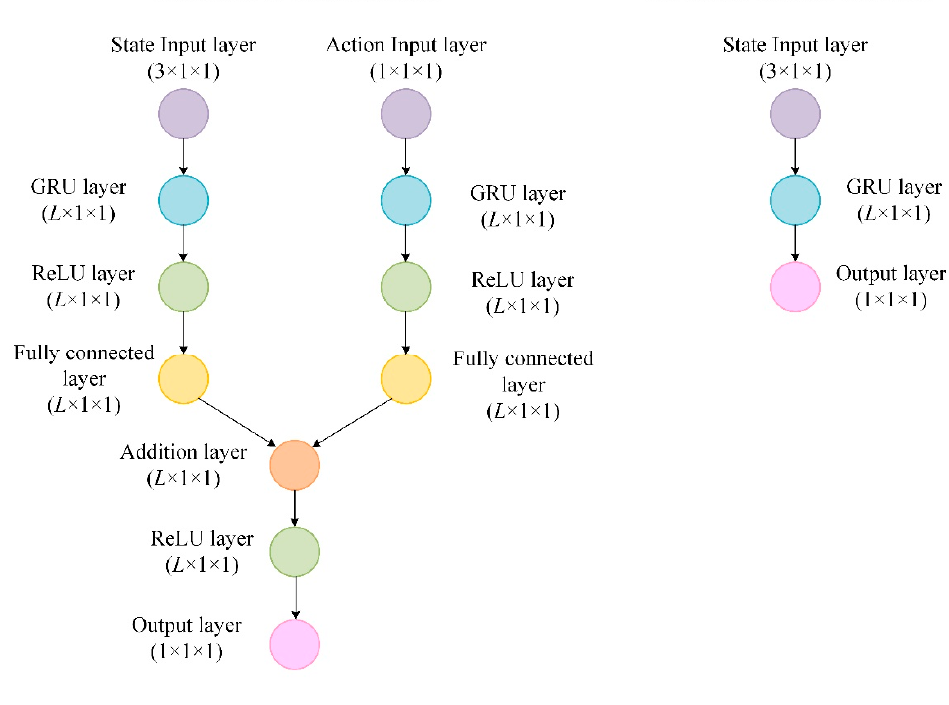
Figure 7. Structures of critic and actor networks for the RL pH controller.